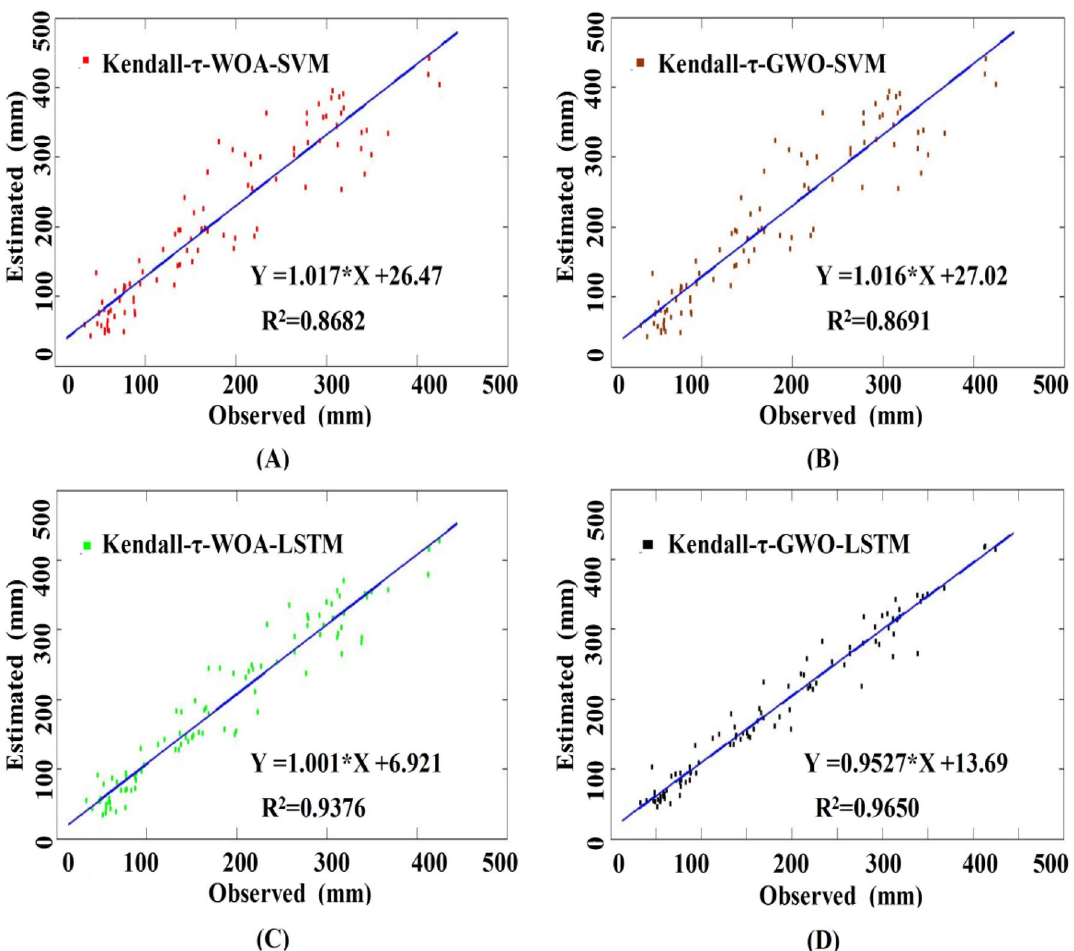
Figure 5. The scatter plots of the observed and estimated results of the proposed models. The blue line inside each panel denotes the fitted line between the observed and estimated results with the coefficient of determination (R 2 ). ( A ) The results of the hybrid Kendall-τ-WOA-SVM model with C = 339.44 and G = 0.013. ( B ) The results of the hybrid Kendall-τ-GWO-SVM model with C = 145.35 and G = 0.013. ( C ) The results of the hybrid Kendall-τ-WOA-LSTM model with NHL = 63, NHU = 76, E = 46, MBS = 29, and LR = 0.005. ( D ) The results of the hybrid Kendall-τ-GWO-LSTM model with NHL = 47, NHU = 93, E = 57, MBS = 20, and LR =